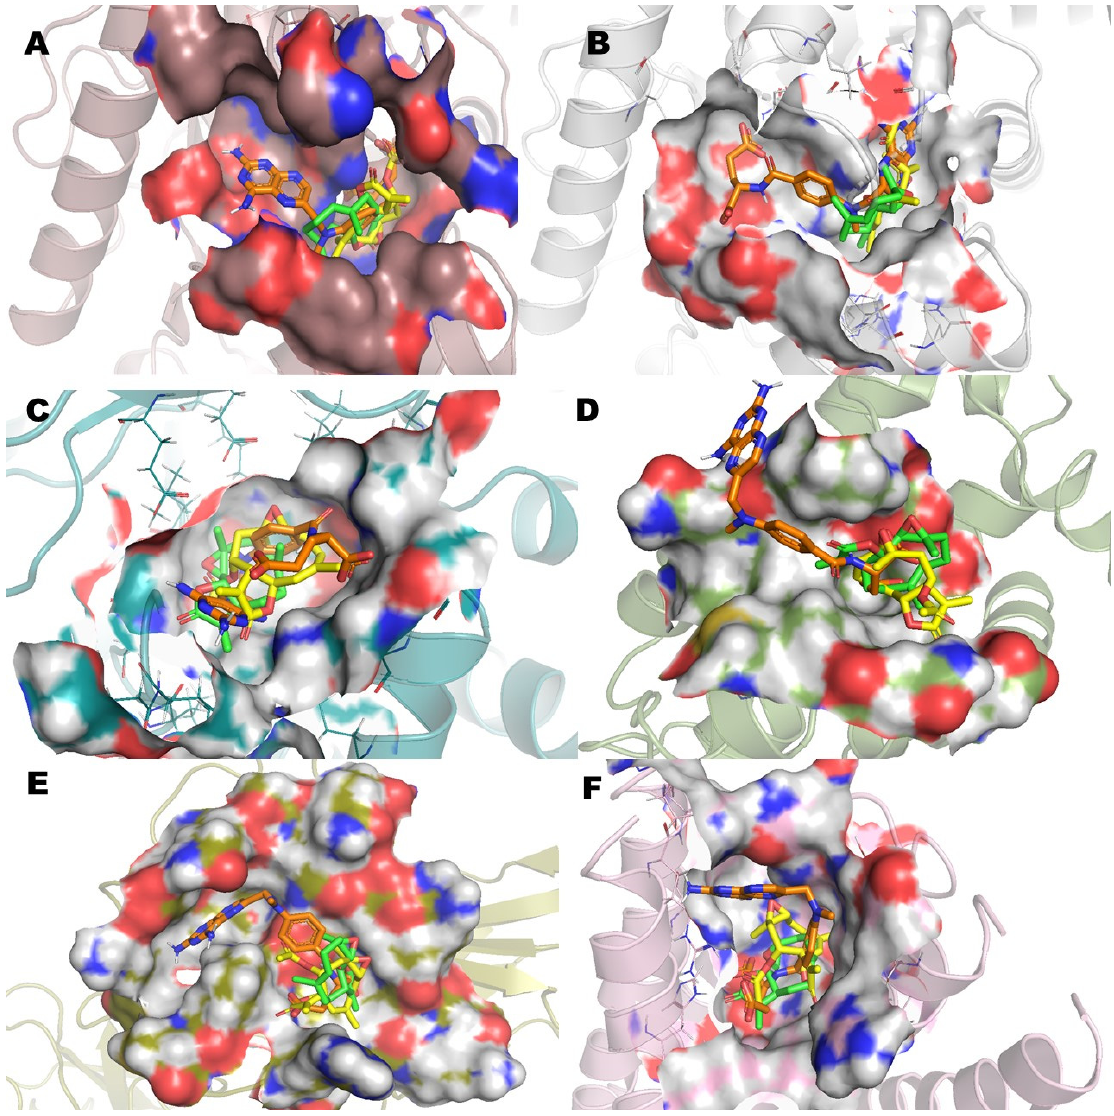
Figure 5. Superimposed poses of methotrexate ( MTX ), parthenolide ( Pa ), and incomptine A ( IA ) into the binding site bound to ( A ) L-lactate dehydrogease A chain (LHDA), ( B ) L-lactate dehydrogenase B chain (LDHB), ( C ) Fructose-bisphosphate aldolase (ALDOA), ( D ) Bcl-2-regulator protein A1 (BCL-2A1), ( E ) NF-kappa B p65 (RelA) homodimer (NFkB), and ( F ) Microsomal glutathione S-transferase 1 (MGST1).